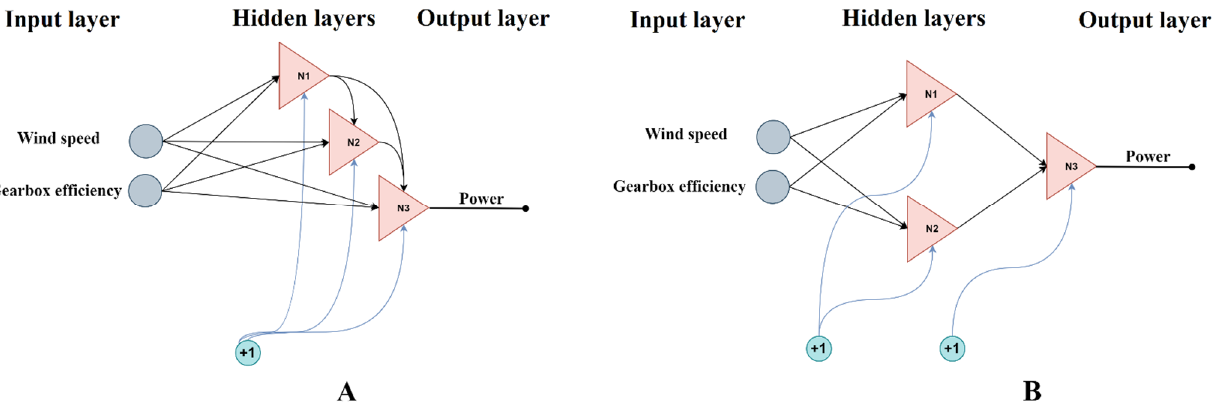
Figure 6. ANN architectures for power predictions. ( A ) 2 inputs, 1 output FCN; ( B ) 2 inputs, 1 output MLP 2-2-1 (N is the neuron index).